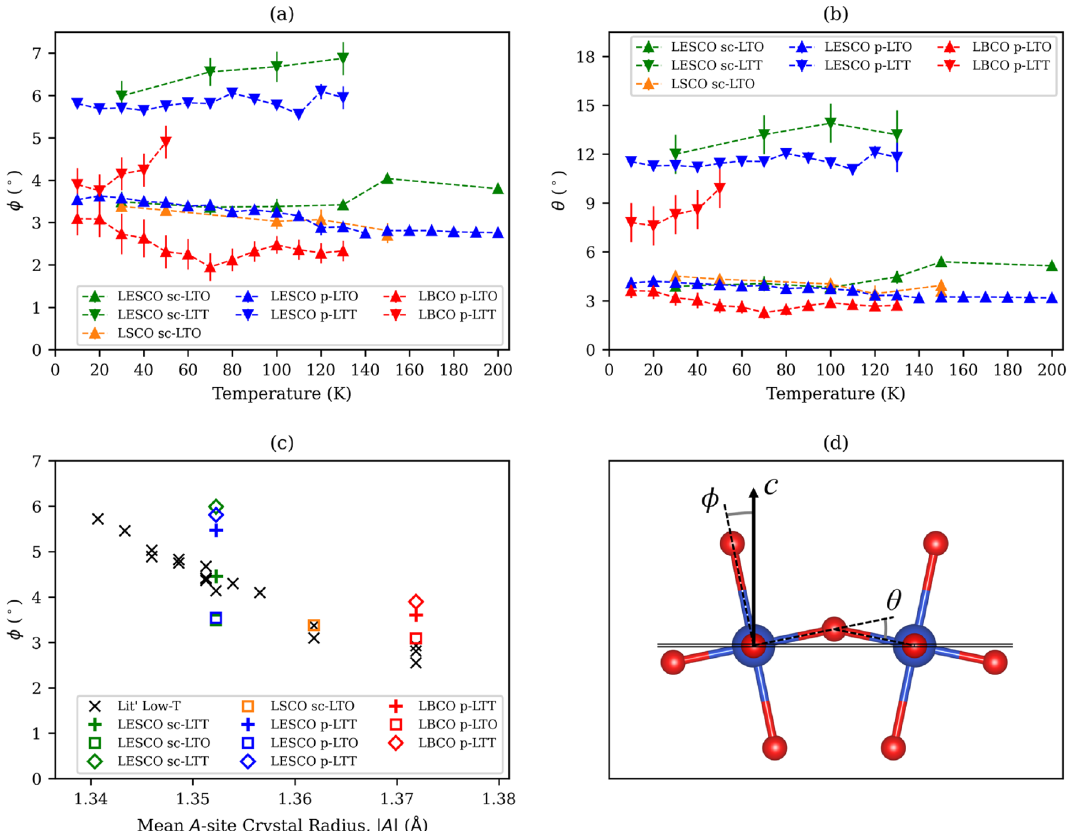
Figure 3. Plots of ( a ) the octahedral tilt angles, φ , and ( b ) Cu–O eq –Cu’ bond buckle, θ , for the appropriate refinements of both pXRD (“p−”) and scXRD (“sc−”)data sets with error bars drawn at 3σ confidence level; ( c ) φ as a function of the average crystal radii 44 of the doped A -site found in the literature 10,23,45–47 for (La,Nd,Eu) 1.875 (Ba,Sr) 0.125 CuO 4 ( y = 0.2–0.8 for Nd, 0.2 for Eu), those obtained for the LTO+LTT and single- phase LTT models for LESCO and LBCO, and LTO mode for LSCO, discussed in the text. ( d ) Diagram of two corner-sharing CuO 6 , viewed in the equatorial plane, showing the identity of angles θ and φ . We omit LTT parameters in ( a ) and ( b ) where the phase fraction falls below 15% and their refinement grows unreliable. See Supplemental Figs. 11 and 12 for symmetry adapted distortion mode amplitudes and cell parameters,